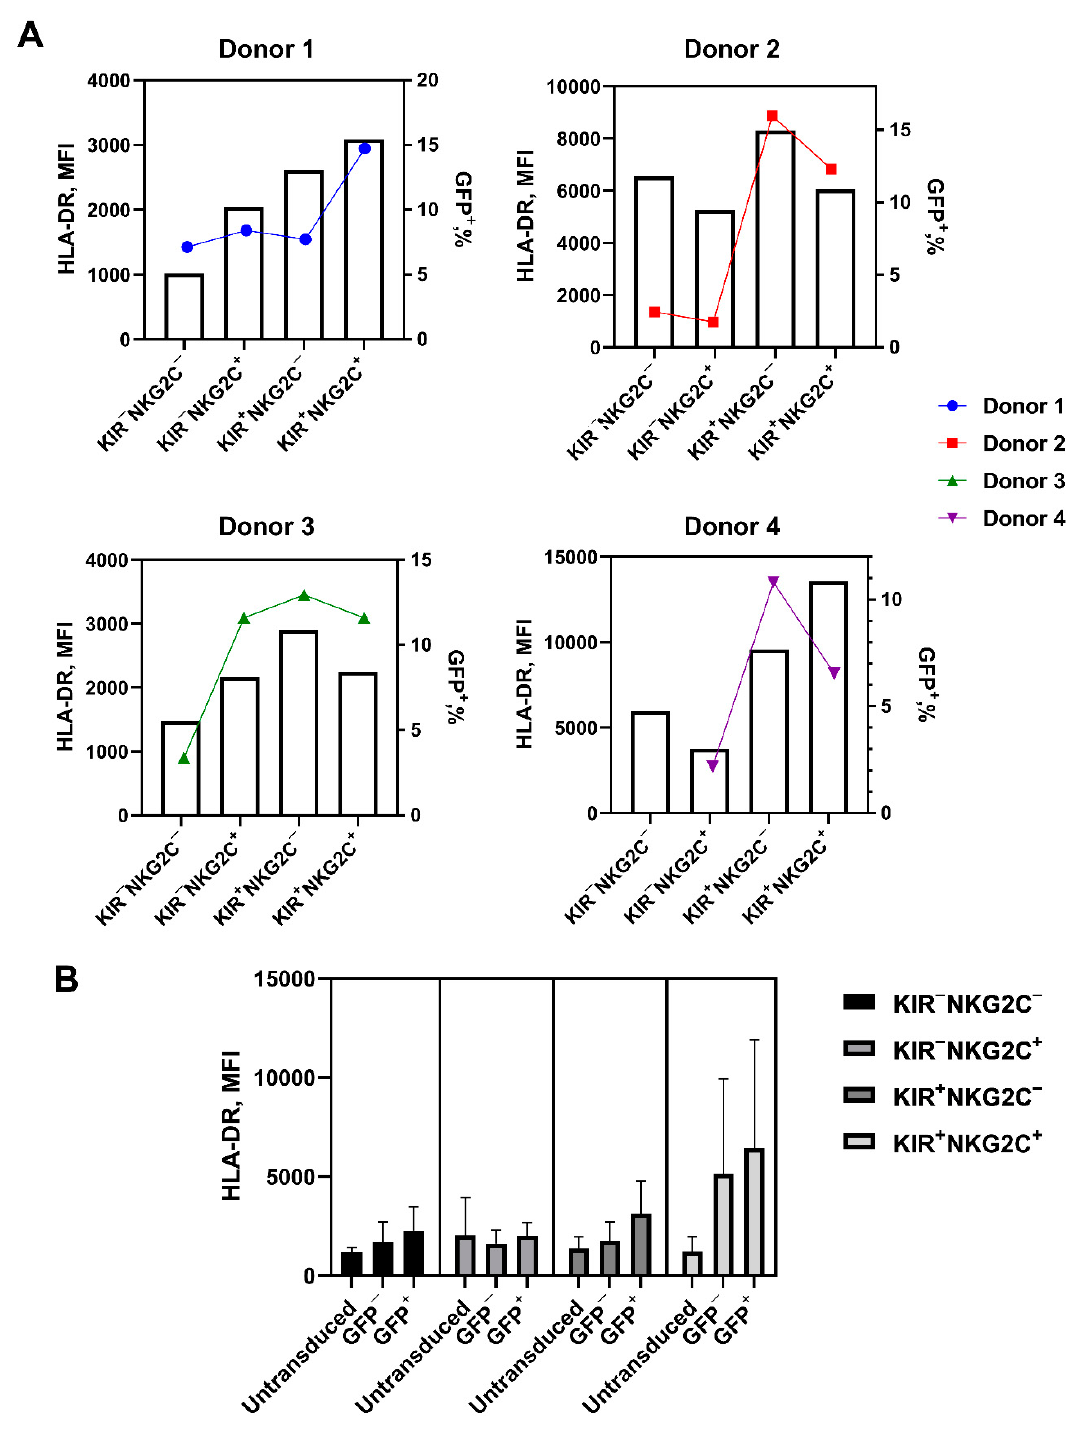
Figure 6. HLA-DR expression level in the cultures of transduced and untransduced NK cells from the subpopulations that initially did not express CD57 and differed in the expression of NKG2C and KIR2DL2/3. ( A ) HLA-DR expression level in the cultures of the studied subsets from the four individual donors after 7 days of stimulation with IL-2 and feeder cells. The left Y axis is HLA-DR expression level (bars). The right Y axis is the transduction level (colored dots and lines). ( B ) HLA-DR surface expression level in the cultures of the transduced and untransduced NK cells from the studied subpopulations on day 7, after the transduction.